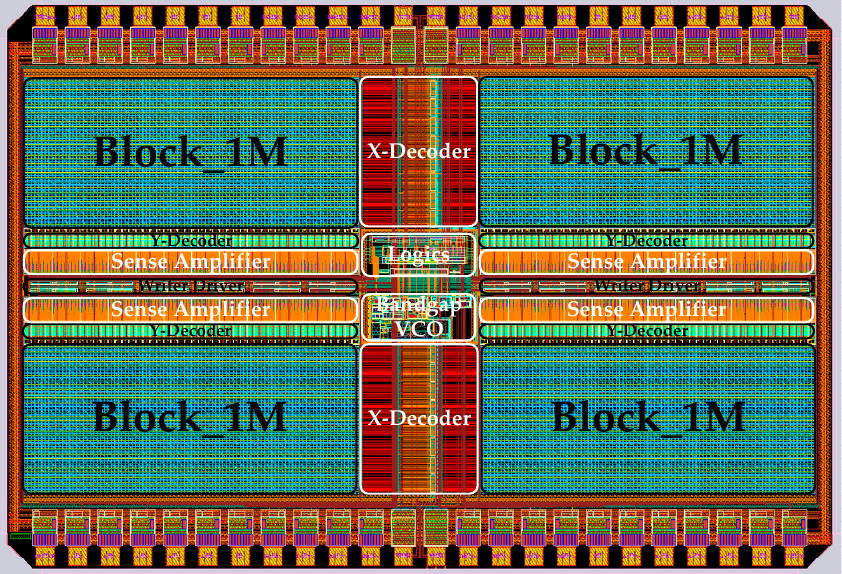
Figure 6. The layout of the 4 M 2-bit/cell phase change memory chip.